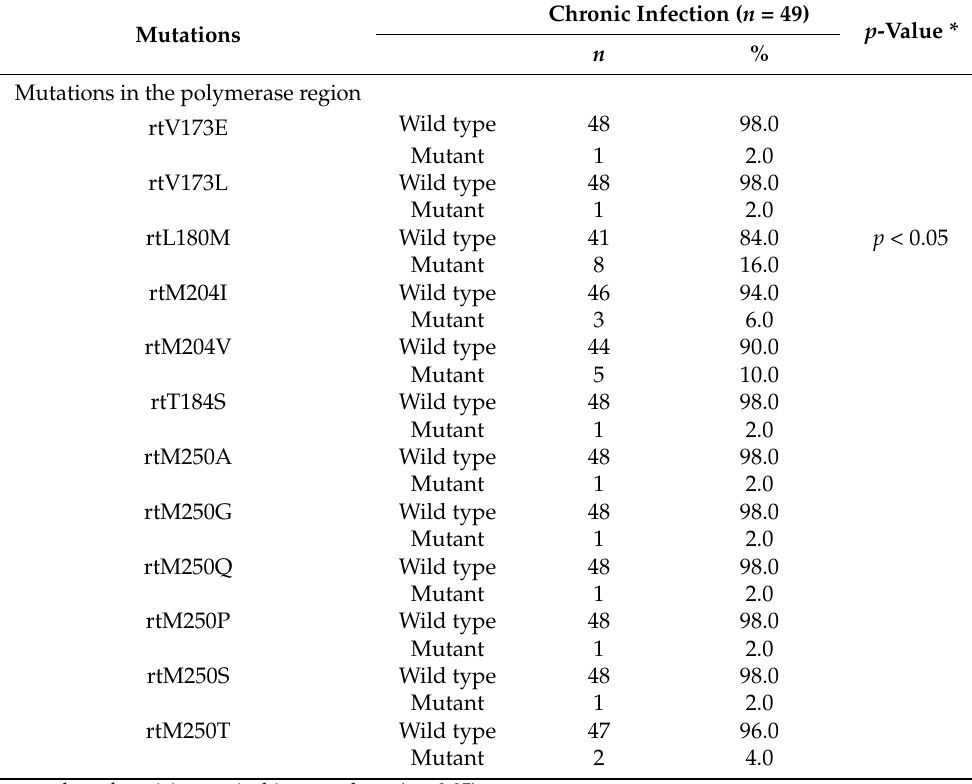
Table 6. Analysis of polymerase